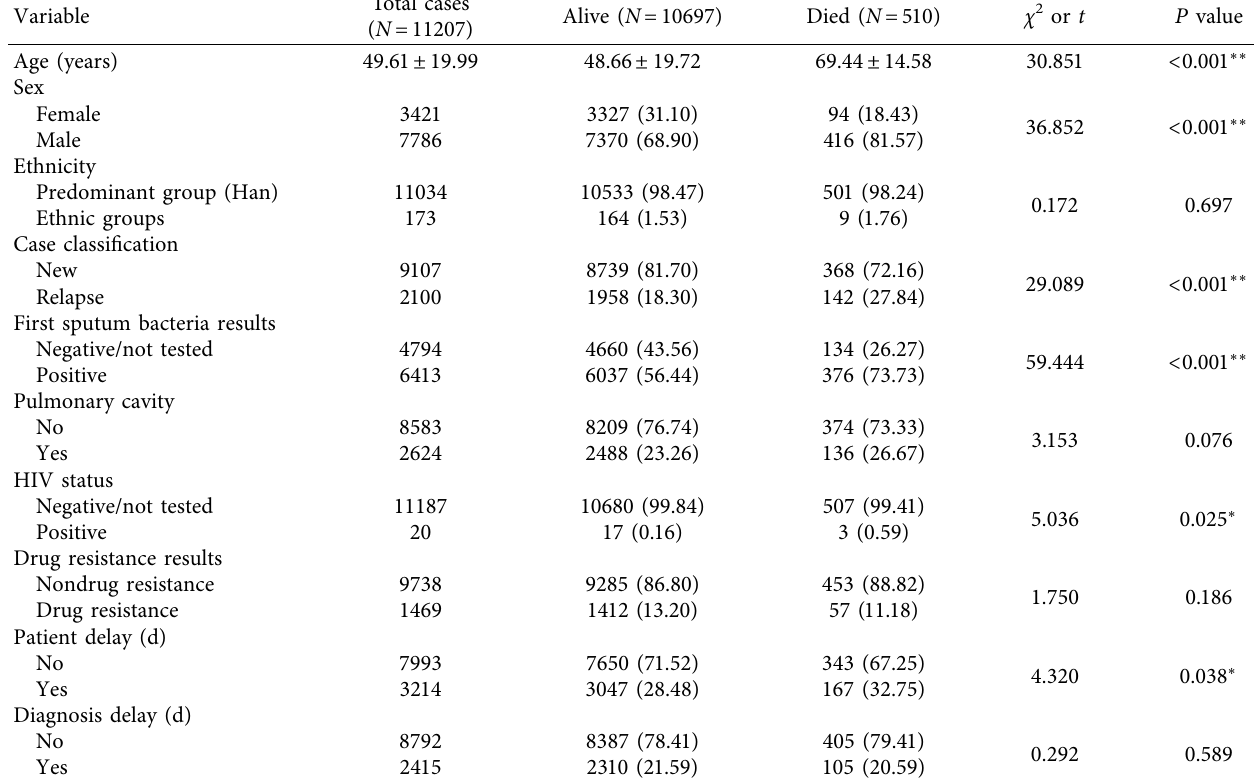
Table 1: Patient clinical characteristics and statistical analysis of the death status.